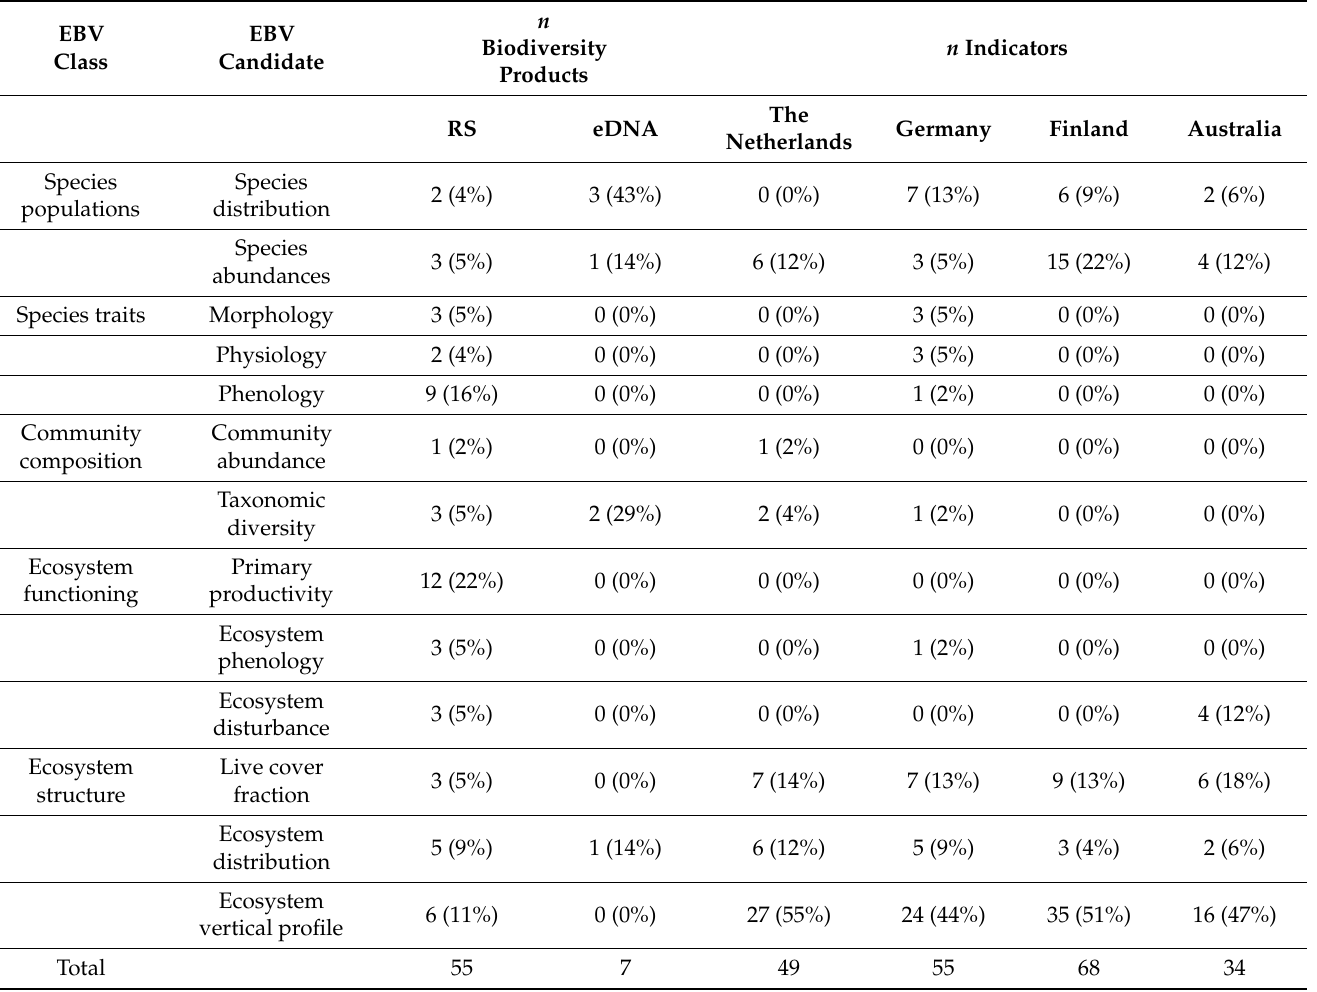
Table 1. The number (counts) of RS/eDNA biodiversity products and forest conservation indicators from the four countries that could be categorized into the different EBVs classes and